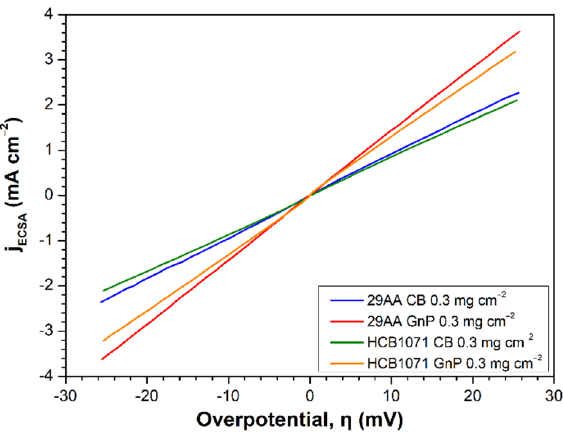
Figure 6. ( a , b ) Polarisation curves and ( c , d ) bromide oxidation/bromine reduction cycling potential responses at ±500 mA cm − 2 for 10 min oxidation, followed by 10 min reduction reaction, obtained on carbon paper (29AA) electrodes ( a , c ) and carbon cloth (HCB1071) electrodes ( b , d ). Electrolyte stirred at 1500 rpm; 3 M HBr/1 M Br 2 electrolyte; temperature, 298 K.